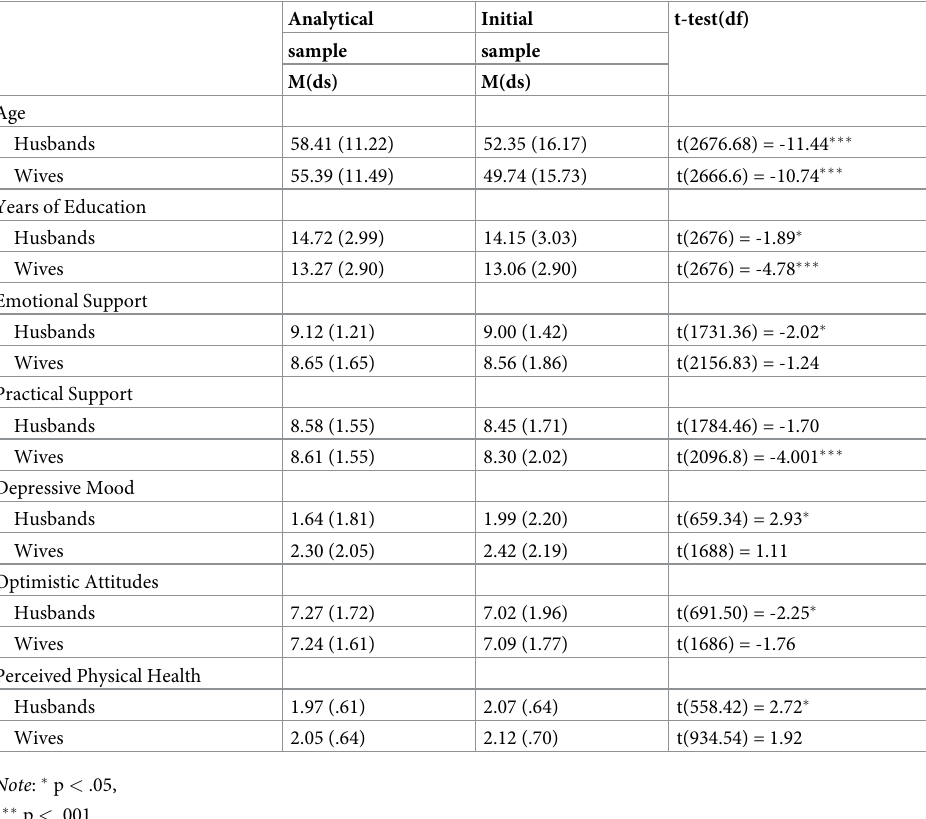
Table 1. Independent sample t-tests comparing the initial and the analytical